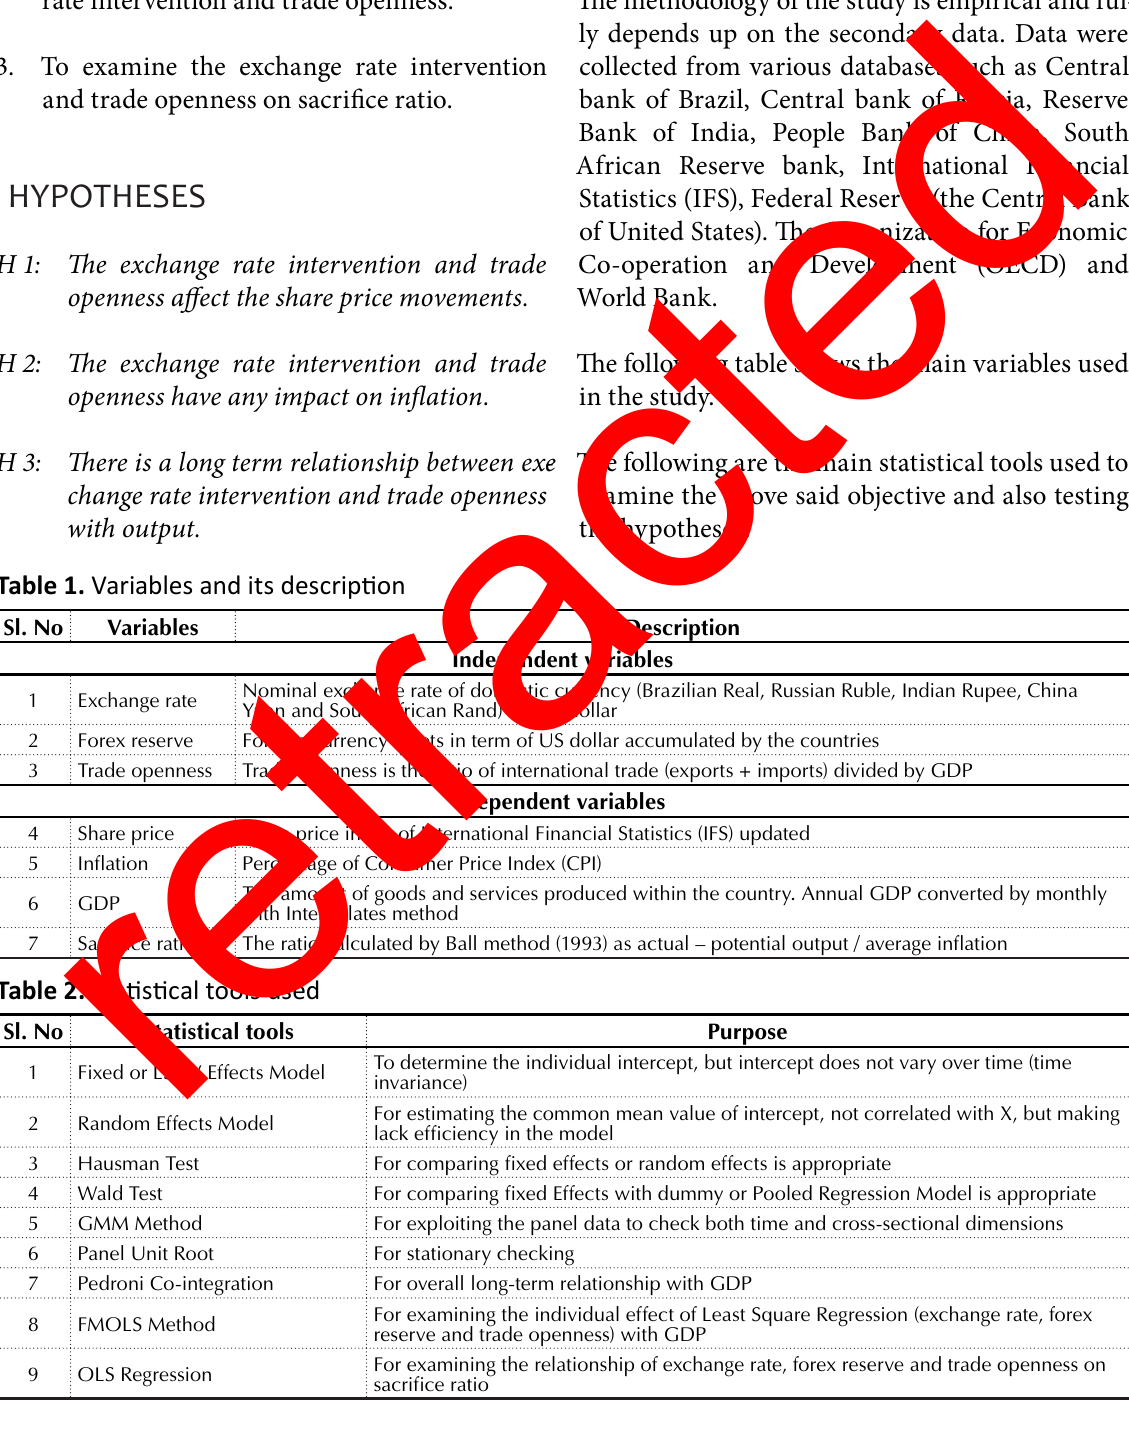
Table 2. Statistical tools used Sl. No Statistical tools Fixed or LSDV Effects Model